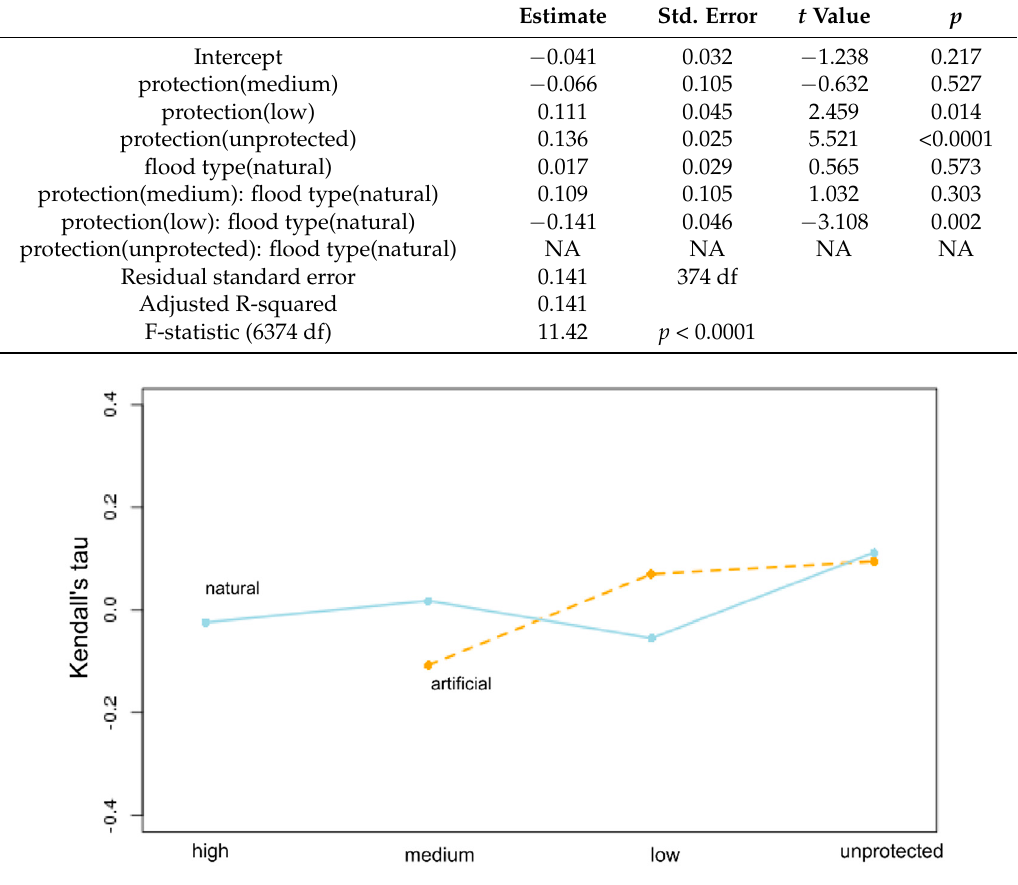
Figure 10. Interaction plot of hydroperiod trend (Kendall’s tau) between protection level (high = National Park, medium = Natural Park, low = Biosphere Reserve) and type of flooding: natural = blue, or artificial = orange. n = 381 photo-interpreted water bodies.